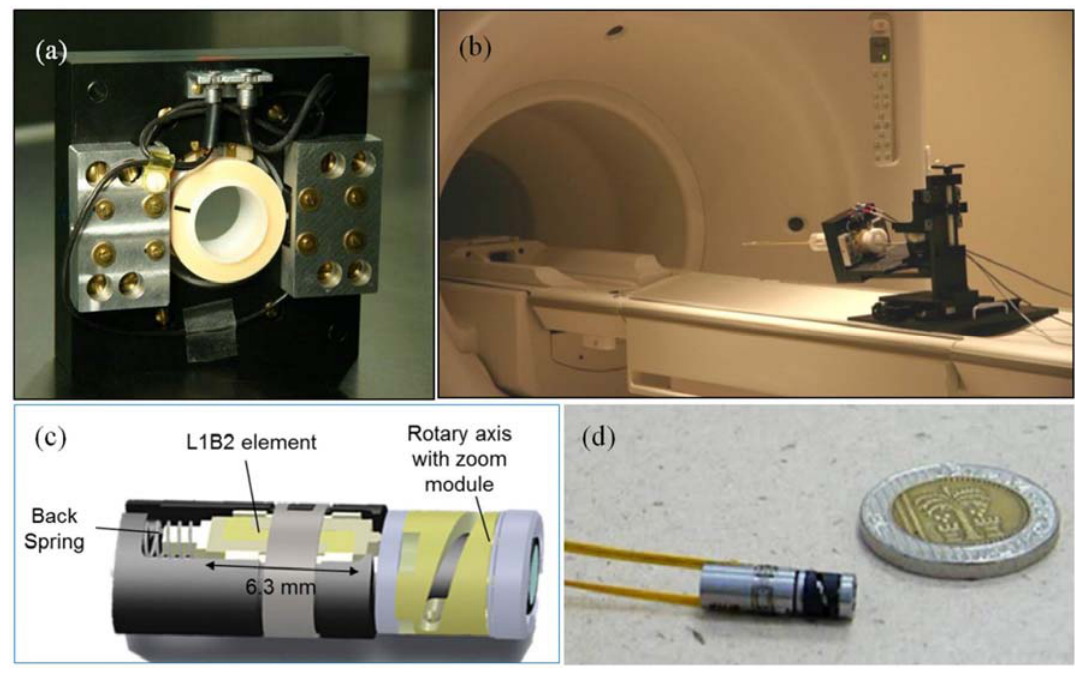
Figure 14. Examples of L1B2 motor use in biomedical applications: ( a , b ) Two Nanomotion HR2-V motors are used to rotate a shaft in a tumor ablation instrument operating inside an MRI instrument having a magnetic field of 3 Tesla. ( c ) Schematic drawing of a rotary module designed to provide zoom capabilities for endoscopy tools. ( d ) An image of the module that is schematically shown in ( c ).